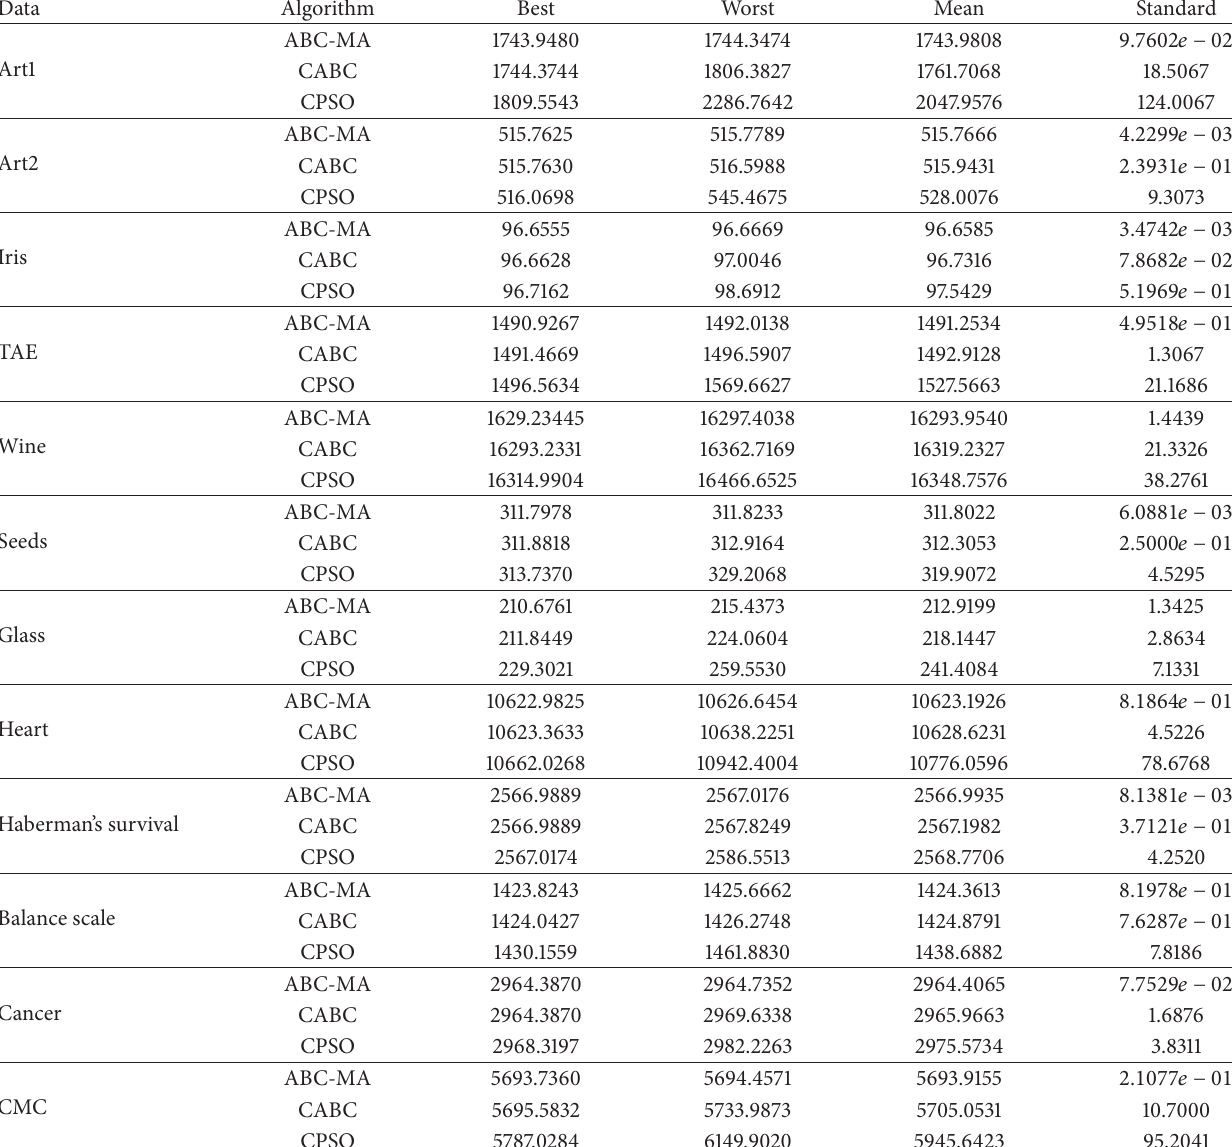
Table 13: Results obtained by the algorithms for 20 different runs on all data